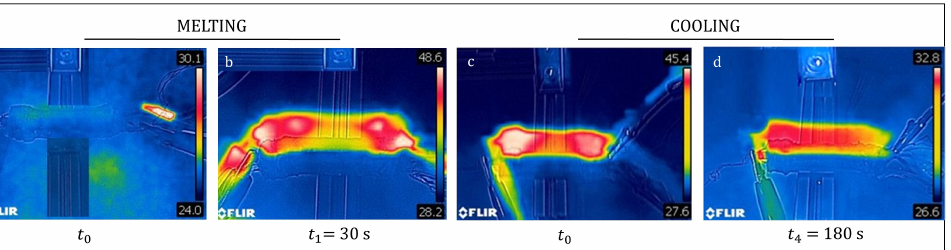
Figure 9. Qualitative thermal analysis of the LMPA module during the transition from ( a , b ) the stiff to the soft state and ( c , d ) the soft to the stiff